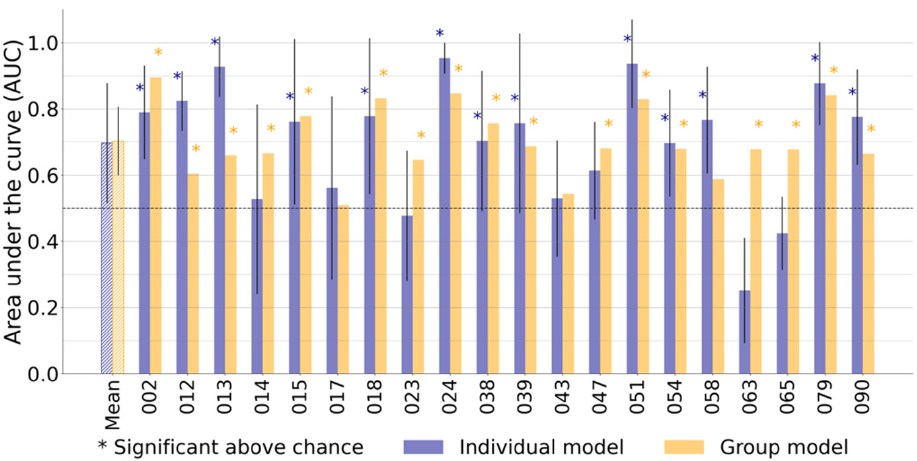
Figure 3. Classification of medication induced motor fluctuations on short accelerometer time windows in individual participants. The first pair of bars represents the mean area under the curve (AUC) score over the twenty participants. Each subsequent pair of bars (002 to 090) represents the AUC scores from one participant. The blue bars represent the AUC score for the individual model, and the yellow bars represent the group model. Note that for the individual models, AUC scores are the averages over the multiple cross-validation folds within a participant (Figure 1B). The asterisks indicate whether the corresponding AUC score was significantly better than chance level (5000-repetitions permutation test). Both models have equal mean AUC scores. It is notable that the majority (18 out of 20 of participants) has at least one significant score. Half of the participants yielded a higher AUC score with the individual model than with the group model.